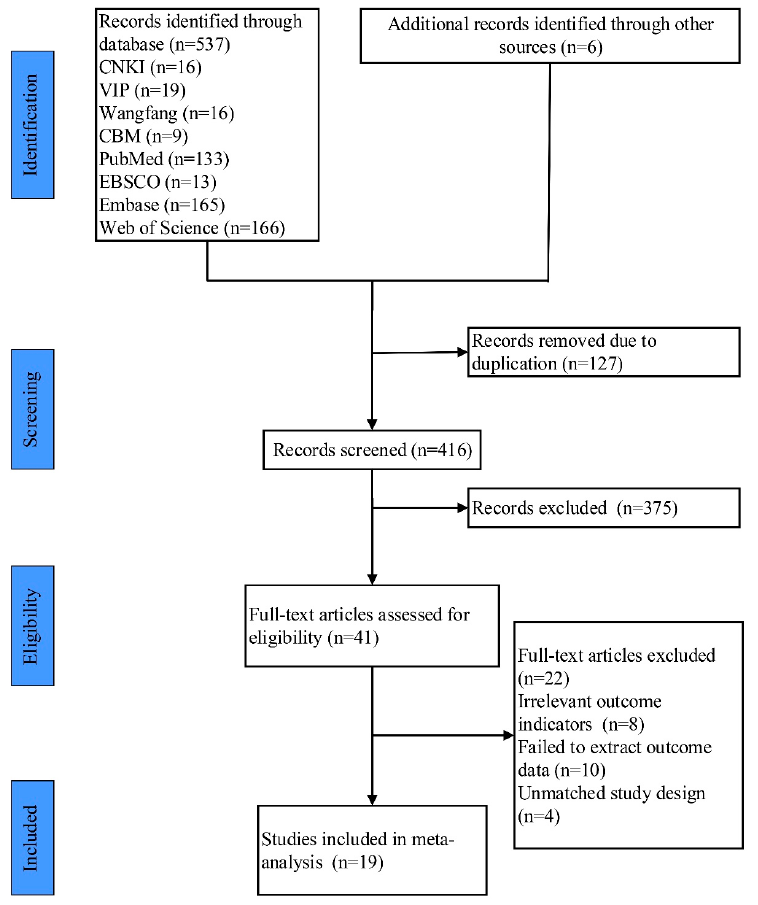
Figure 1. Study selection represented by a PRISMA flowchart. Table 1. The details of the research’s general